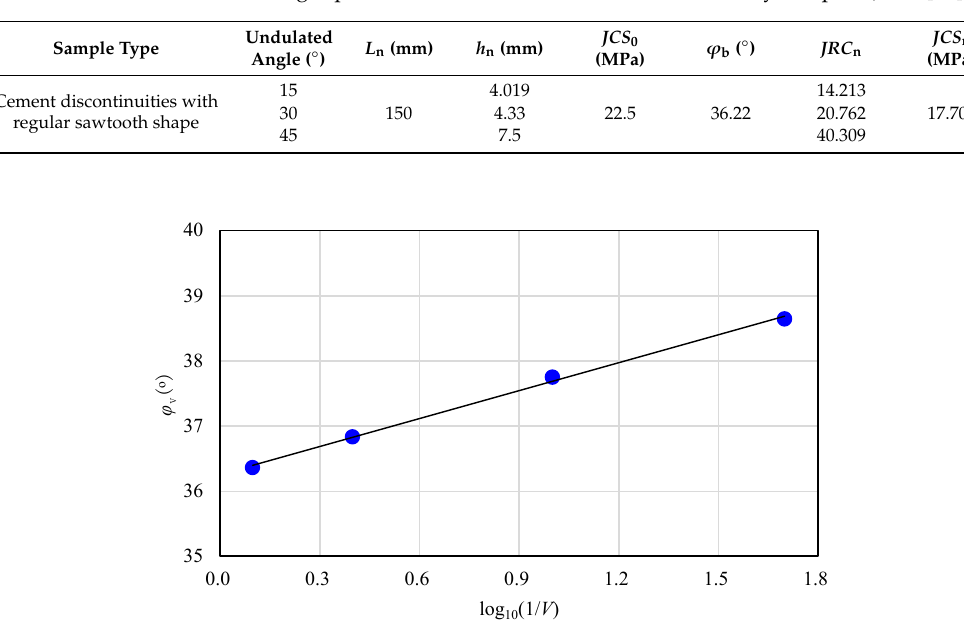
Table 4. Geometric and strength parameters of di ff erent cement discontinuity samples (after [51]).